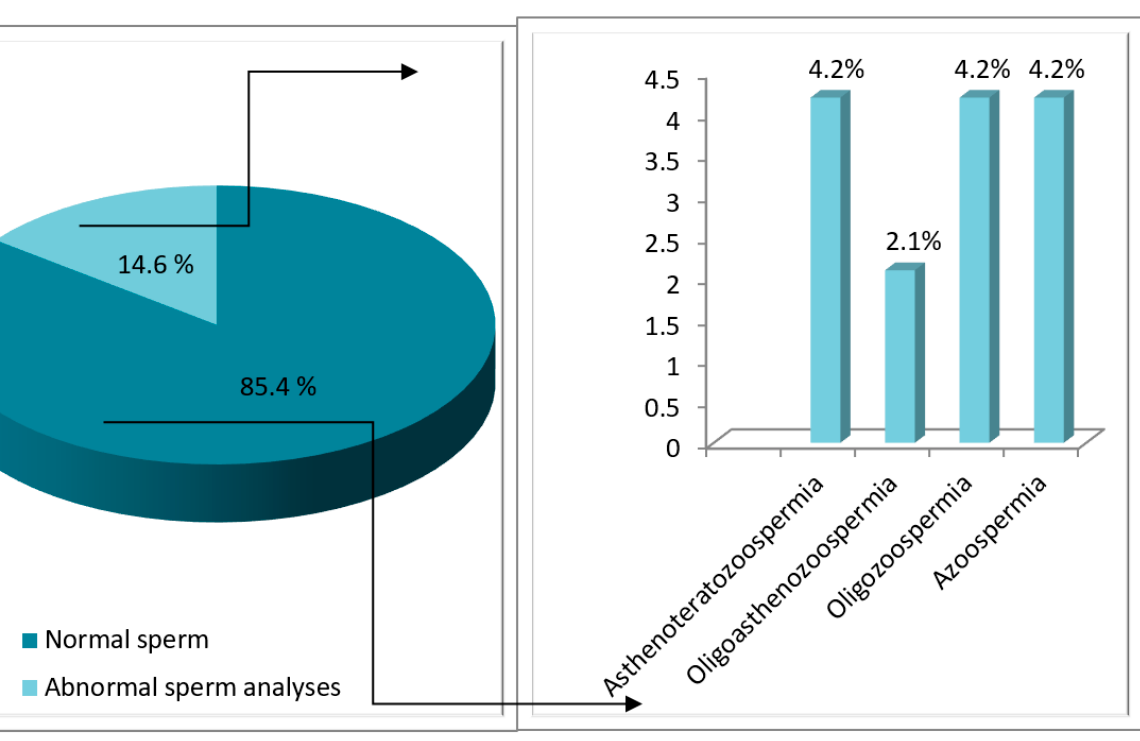
Figure 1. Distribution of HD patients according to spermogram findings prior to treatment. A statistically significant correlation is registered between spermogram findings (nor- mal and pathological) and the initial erythrocyte sedimentation rate (ESR) values below and over 50 (Pearson chi-square= 8.58261, p = 0.003394), showing that 85% of the patients with an abnormality in the spermogram before treatment also had elevated ESRs above